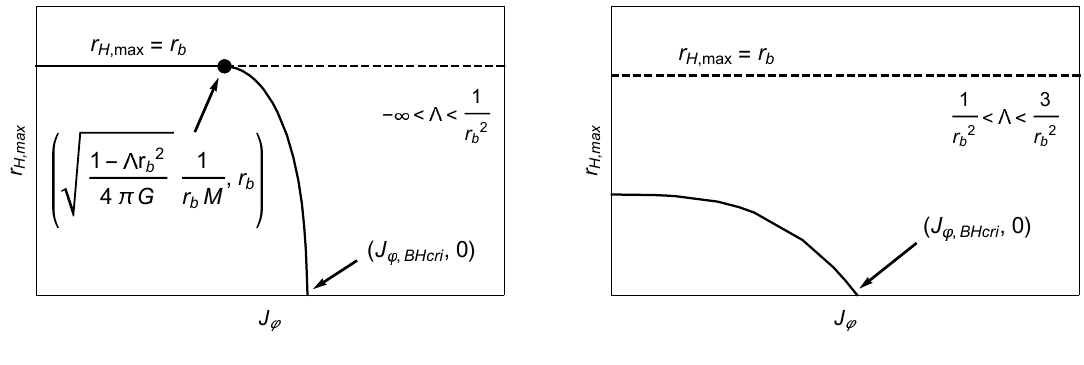
Figure 10 . Qualitative behaviors of r H, max ( r b , Λ , J ϕ , M ) against J ϕ . ( Left ) −∞ < Λ < 1 ( Right ) 1 case. As we increase Λ , the curve shrinks and collapses to the point (0 , 0) < Λ < 3 r 2 r 2 b b when Λ = 3 . r 2 b